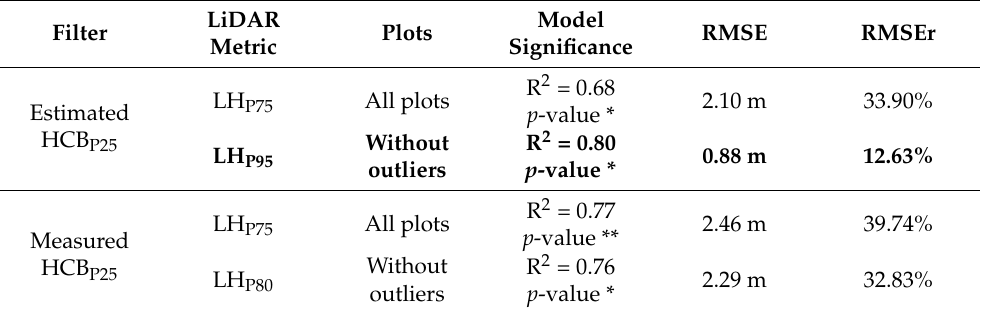
Table 3. Understorey height: Summary error statistics produced by assessing field measurements and LiDAR